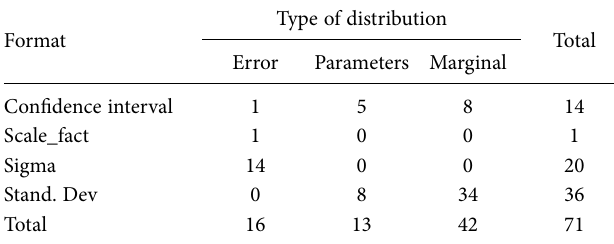
Type of distribution